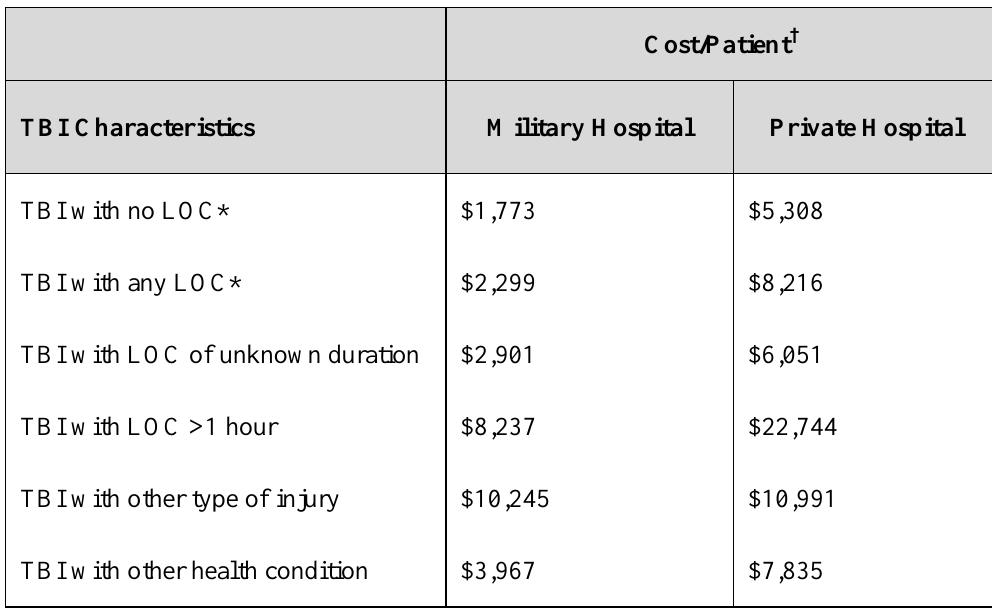
Table 8. Estimated Median Acute Hospitalization Cost per Patient for Military Personnel Hospitalized with TBI (in 2011